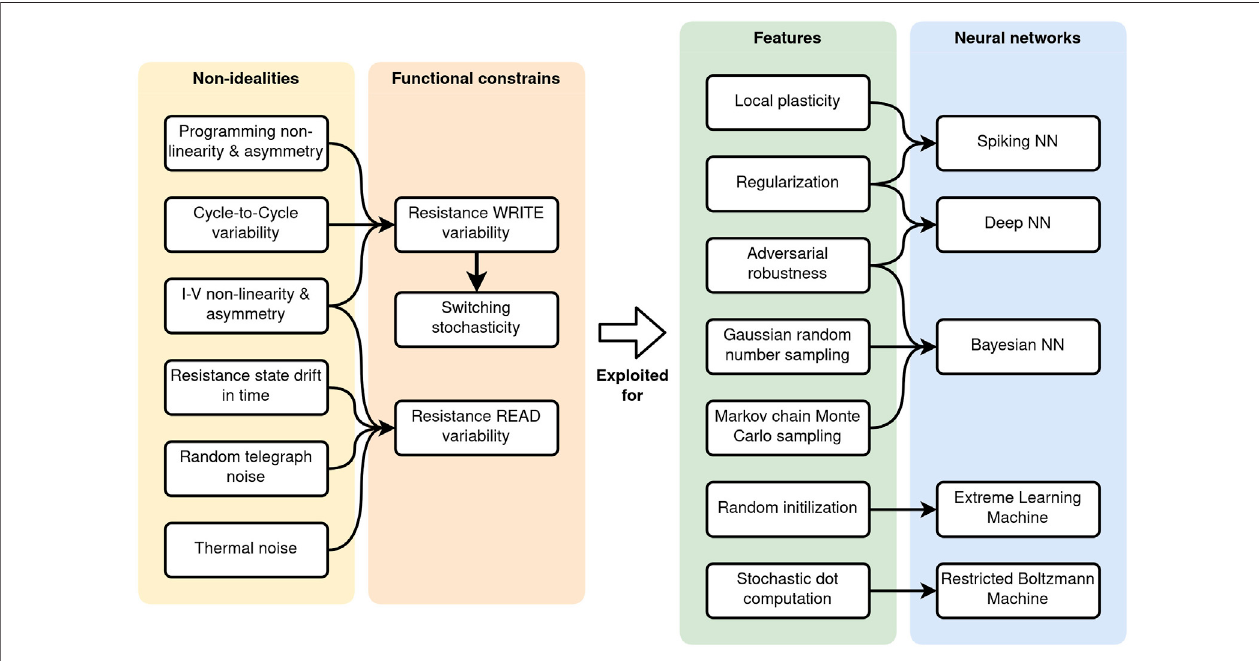
FIGURE1 | Device-level non-idealities in fl uence on RSM functionalconstraintsand their possible usagefor differentNN architectures.The list ofnon-idealities and functional constraints given here is limited to those reported in the literature for these use cases, thus the list is not exhaustive.